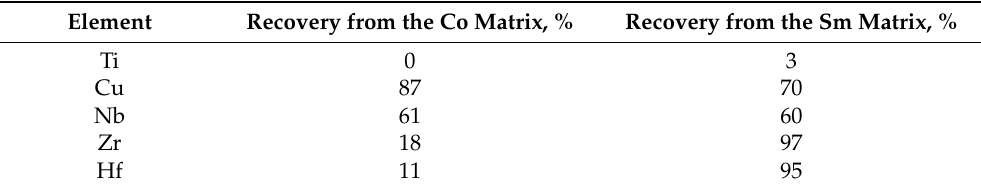
Effect of matrix on recovery. Sorption